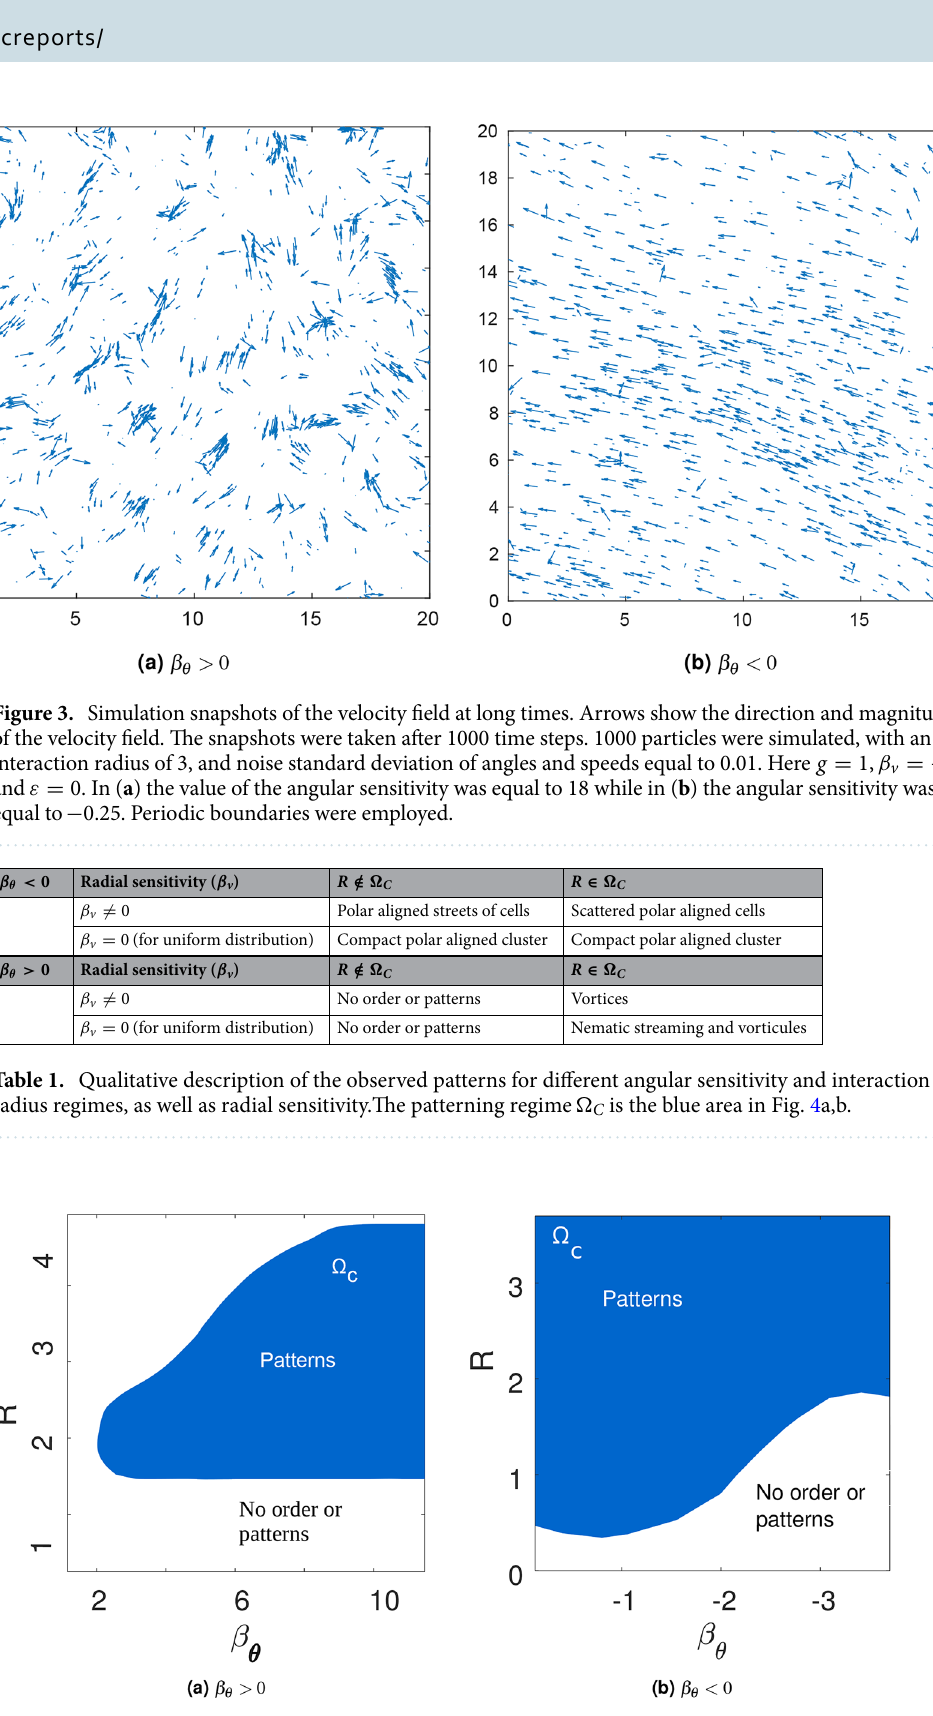
Figure 4. Pattern formation regimes (cid:31) C in the interaction radius—sensitivity plane for positive and negative values of angular sensitivity. In ( a ) there exists an optimal regime where we can find pattern formation. But in ( b ) for negative values of beta we can see patterns at smaller values of interaction radius and at smaller values of angular